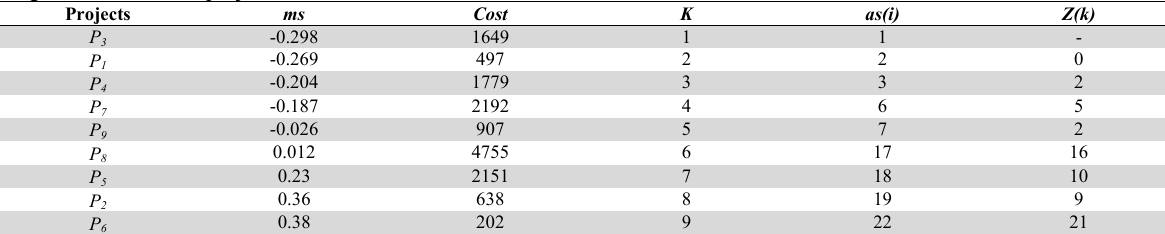
Augmented scores of projects Projects